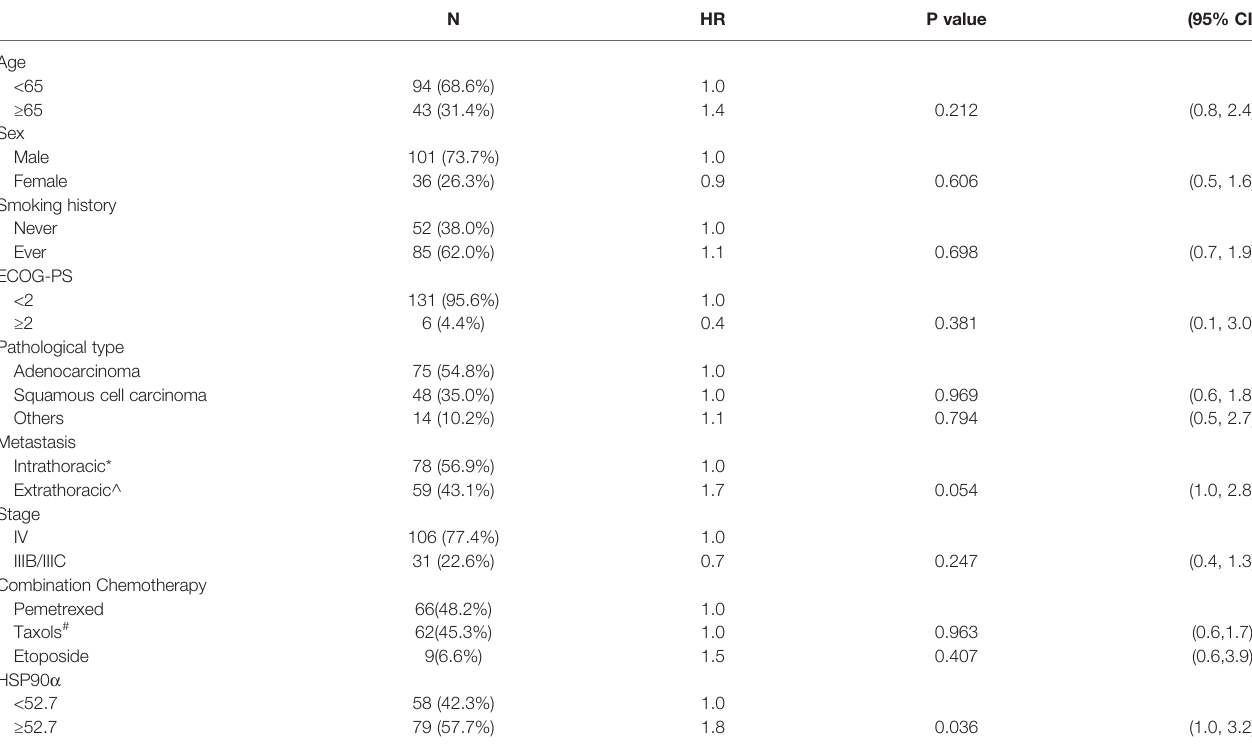
TABLE 2 | Univariate Cox regression analysis of the possible predictive factors for